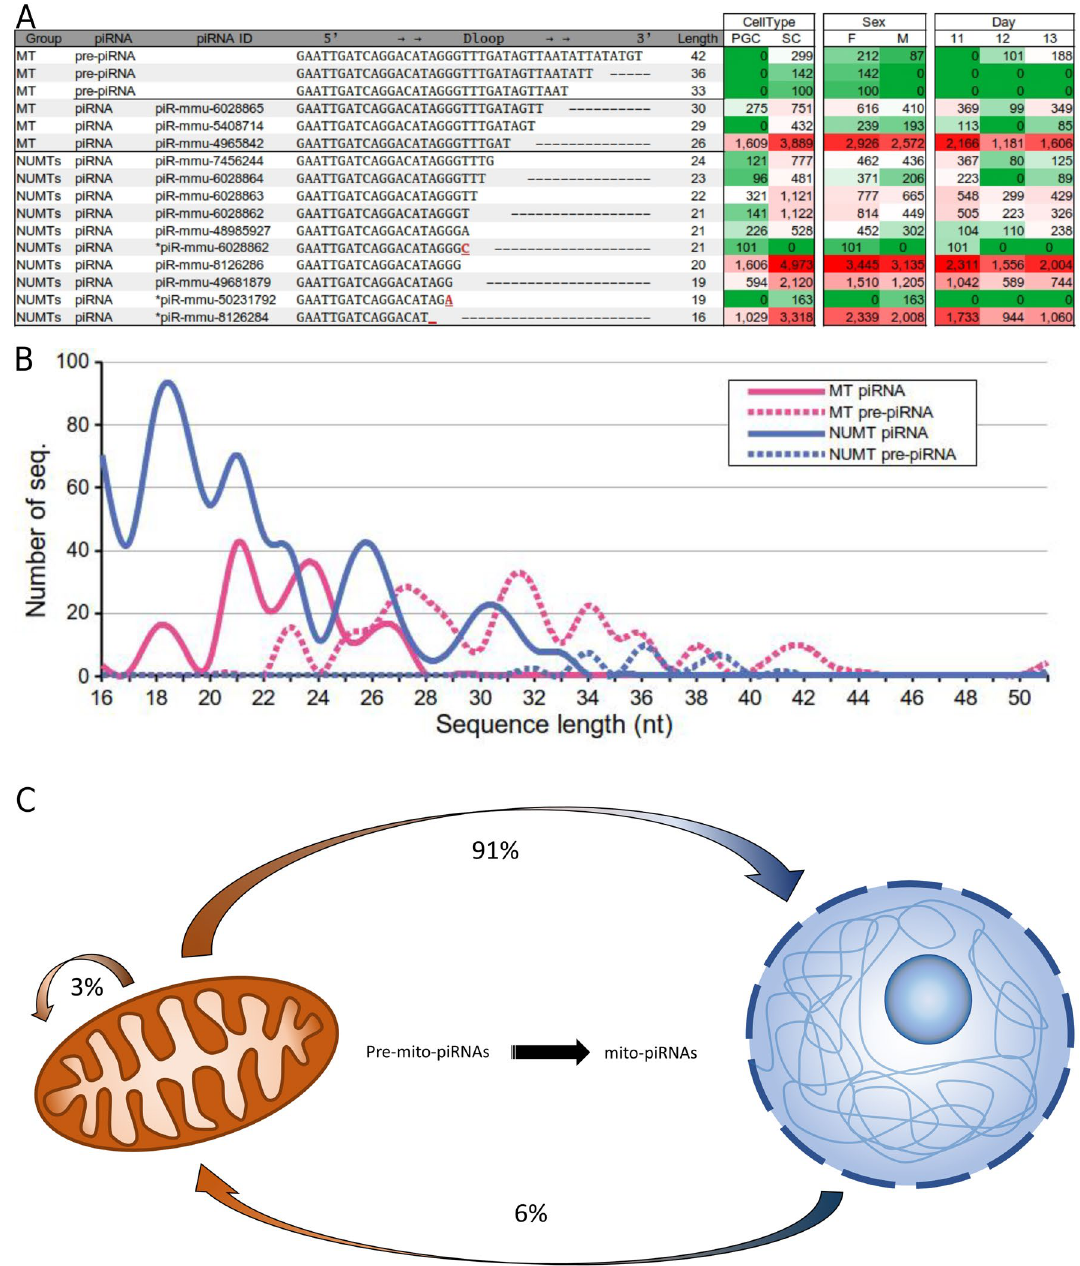
Figure 3. ( A ) Example of a family of mito-piRNAs matching pre-piRNAs exclusively in one region of the mitochondrial D-loop (mtDNA 16,121 to 16,189), where they are mapping multiple mito-piRNAs. The annotation column was added to show the sequence’s matching piRNA ID, and when multiple piRNAs are matched (with the allowed 1 mismatch), an “*” is added before the ID. The expression values are indicated in the attached table, sorted by cell type, sex, and day of development (marked from low, in green, to high, in red). ( B) Distribution of mito-piRNAs and the corresponding pre-piRNAs in relation to sequence length mapping classified as MT or NUMT. ( C) Illustration of expected proportion of mito-nuclear communication mediated by mito-piRNAs in retrograde, anterograde, or self-regulation pathways. The proportions were calculated as the percentages of total detected mitochondrial piRNA families (considering the detected genomic origin of each pre-piRNA and the potential target and were based on sequence complementarity of processed